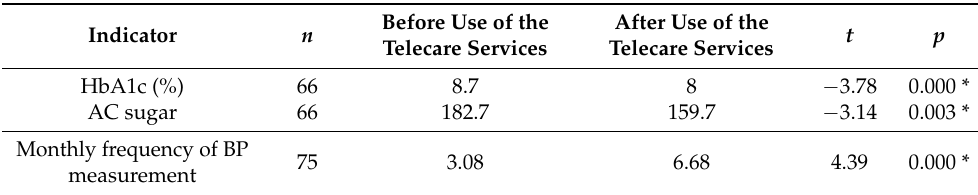
Table 4. Physiological indicators of the